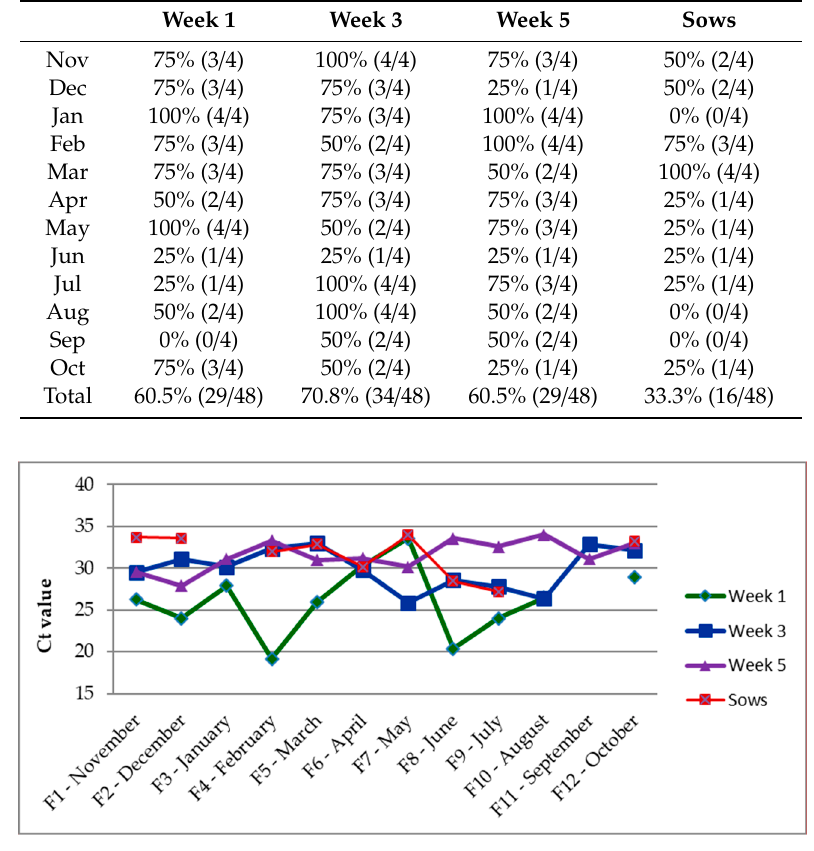
Figure 1. The average Ct value of the influenza A viruses (IAV) positive litters / pens and sows at each sampling time.